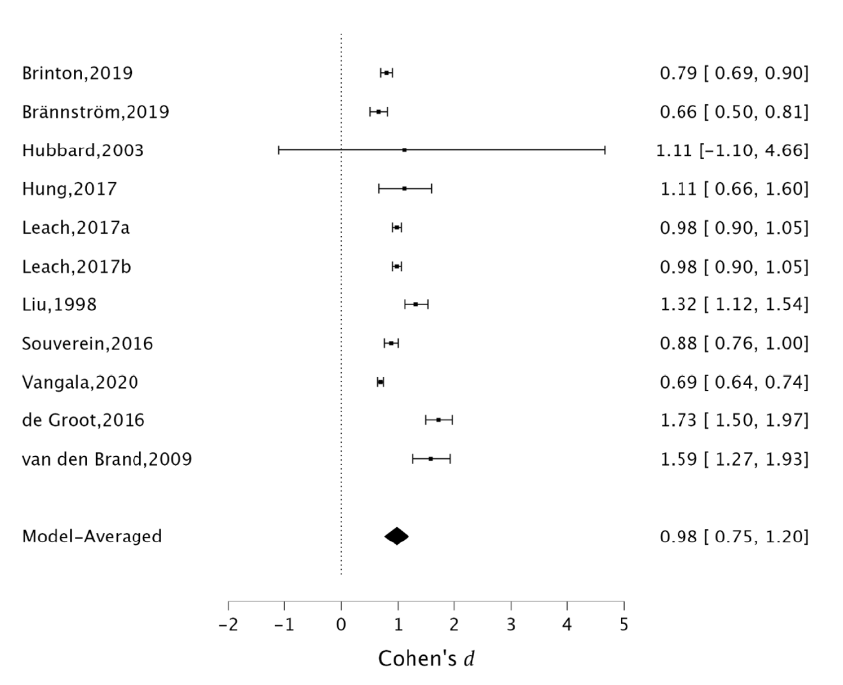
Figure 2. Analysis of pooled effect of SSRIs on increased hip risk fracture. The data was extracted from the following references [24,25,27,30 – 34,37,41,42].